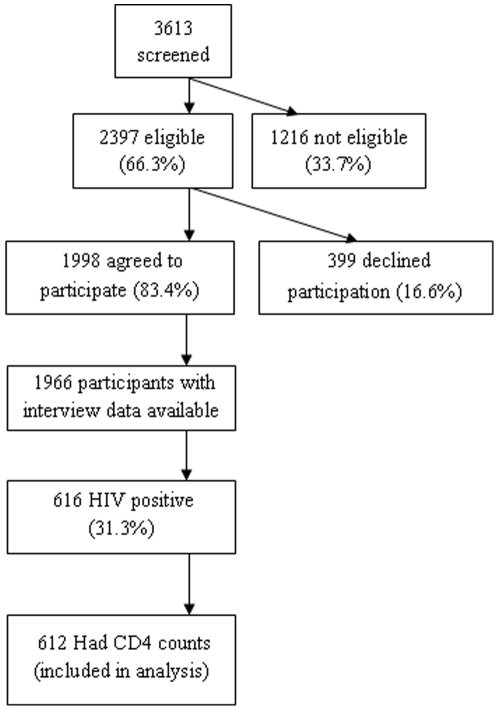
Screening and enrollment of study subjects.This figure shows the number of potential participants screened for eligibility, the number of eligible subjects who agreed to participate and received HIV testing, and the number of HIV infected participants who had CD4 tests.